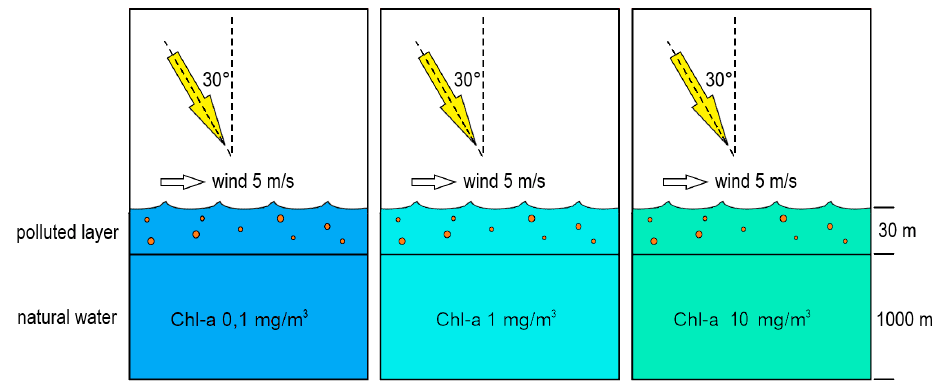
Figure 4. The modeling concept and boundary conditions setup in three types of oceanic waters. Ocean depth was set at 1000 m. Ocean bottom was assumed to be of Lambertian